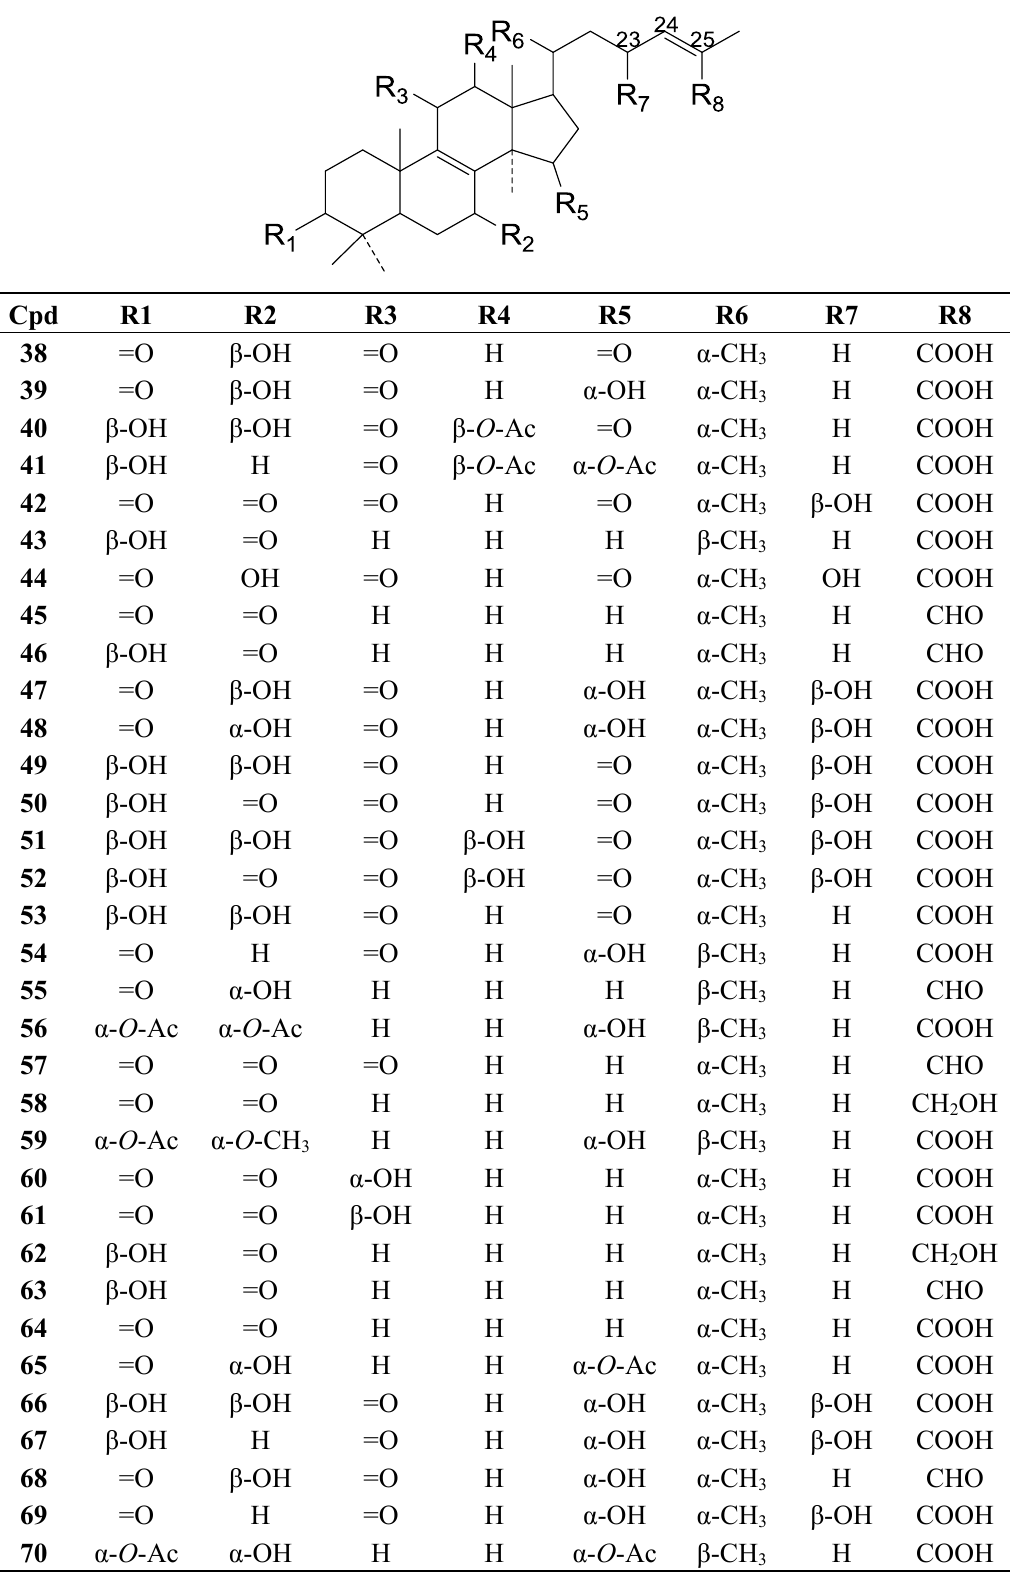
Figure 3. Structures of compounds 38 – 70